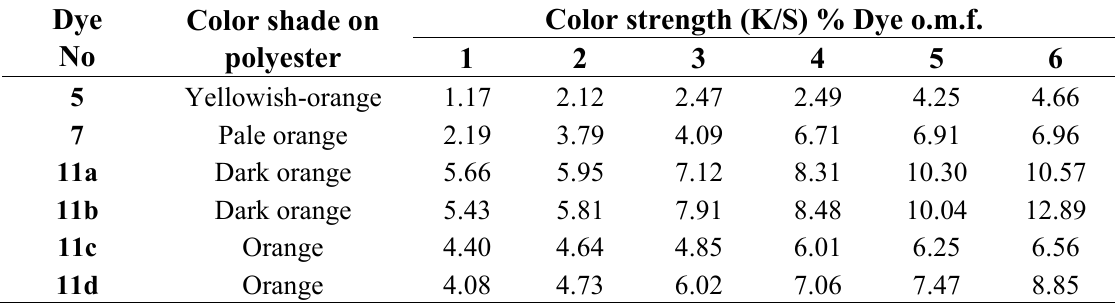
Table 1. Color strengths of azo disperse dyes on polyester fabrics of first dyeing. Dye